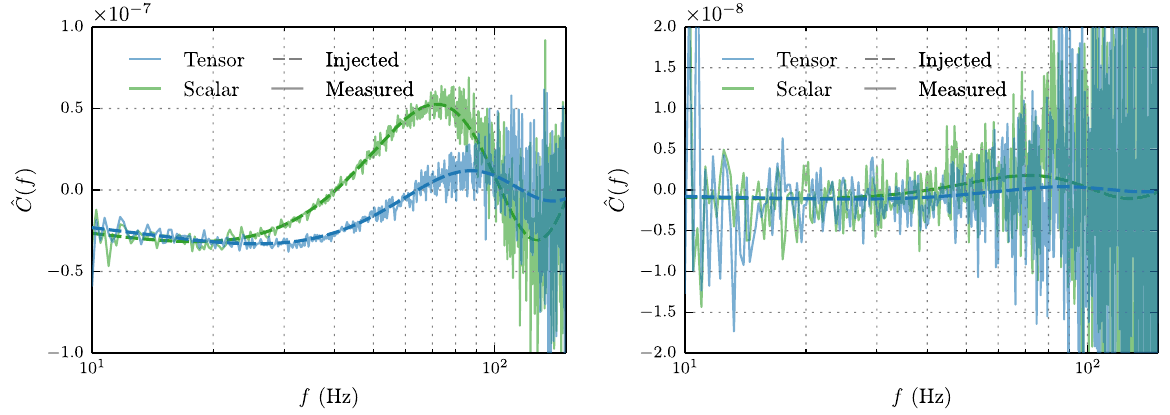
ˆ C FIG. 5. Left: Simulated cross-correlation measurements ð f Þ for purely tensor (blue) and purely scalar (green) stochastic backgrounds, recovered after 3 years of observation with design-sensitivity Advanced LIGO. The backgrounds shown have α α 2 = 3 , and have amplitudes chosen such that each is detectable with h SNR i ¼ 150 . The measured spectra each show T ¼ S ¼ OPT distinct modulations characteristic of the tensor and scalar overlap reduction functions, allowing a clear identification of the polarization in each case. Right: Simulated recovery of weaker tensor and scalar backgrounds, detectable with h SNR i ¼ 5 after 3 years of OPT observation at design sensitivity. While each background would be confidently detected by existing search techniques, the characteristic amplitude modulations and hence the polarization content of each simulated background are no longer